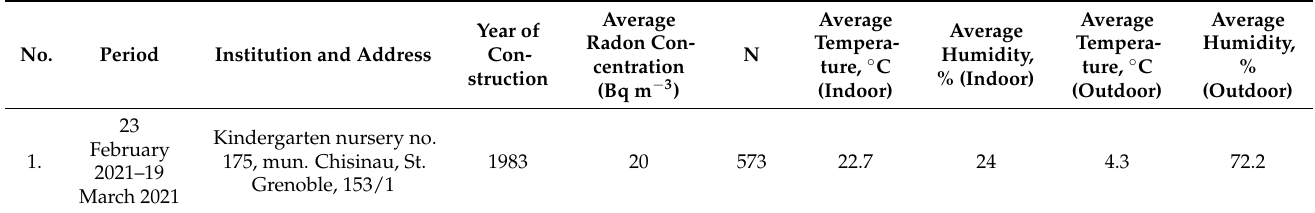
Table A2. The buildings characteristics, abiotic factors and mean value of the radon concentration measured in 2021 survey with RadonEye+ 2 detectors in education institutions in Chisinau municipal- ity and Ialoveni rayon, Republic of Moldova ( n = 49 buildings/N = 23805 measurements; working regime of the device: hourly; measurement